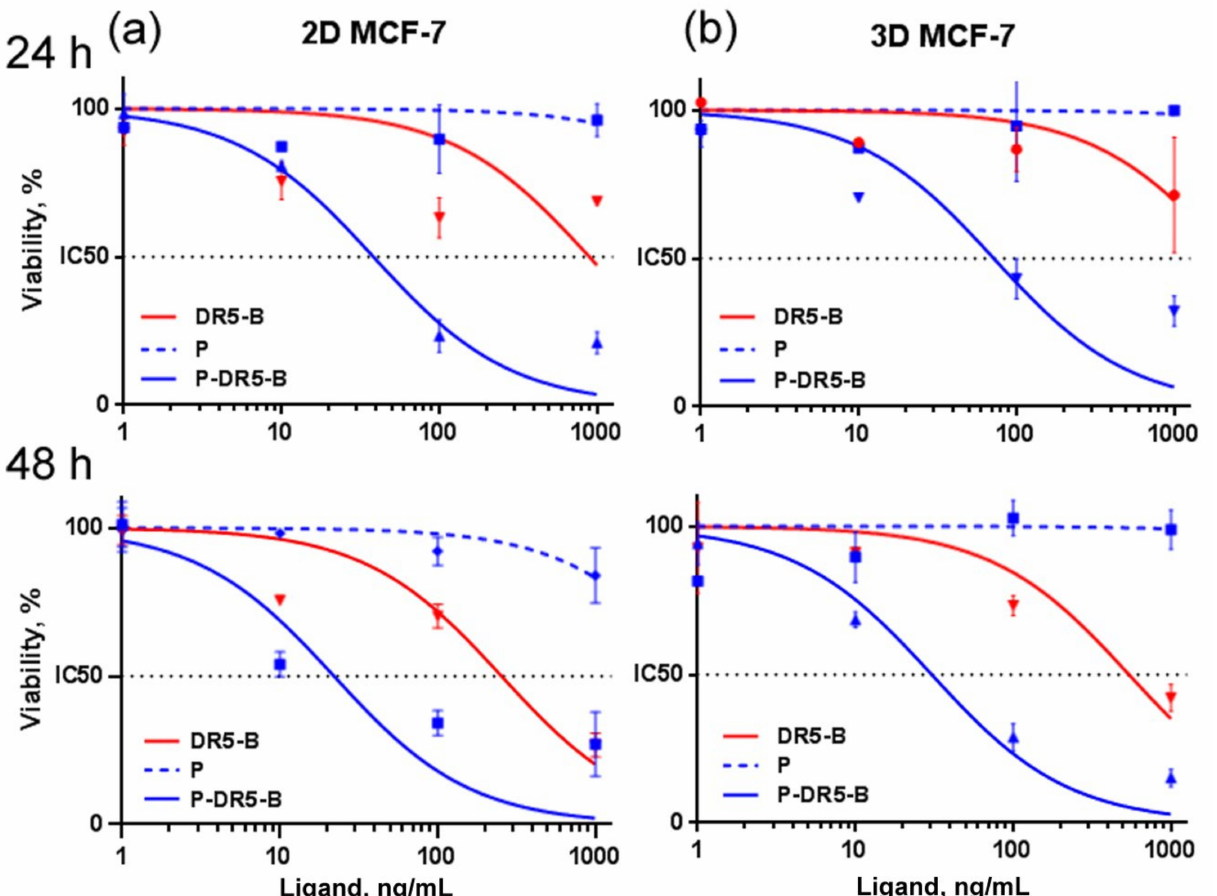
Figure 3. Cytotoxicity of the P-DR5-B nanoparticles in ( a ) 2D and ( b ) 3D human tumor models of breast adenocarcinoma MCF-7 in vitro for 24 and 48 h. Cell viability was determined by the MTT test. Mean ± Standard Deviation ( n =